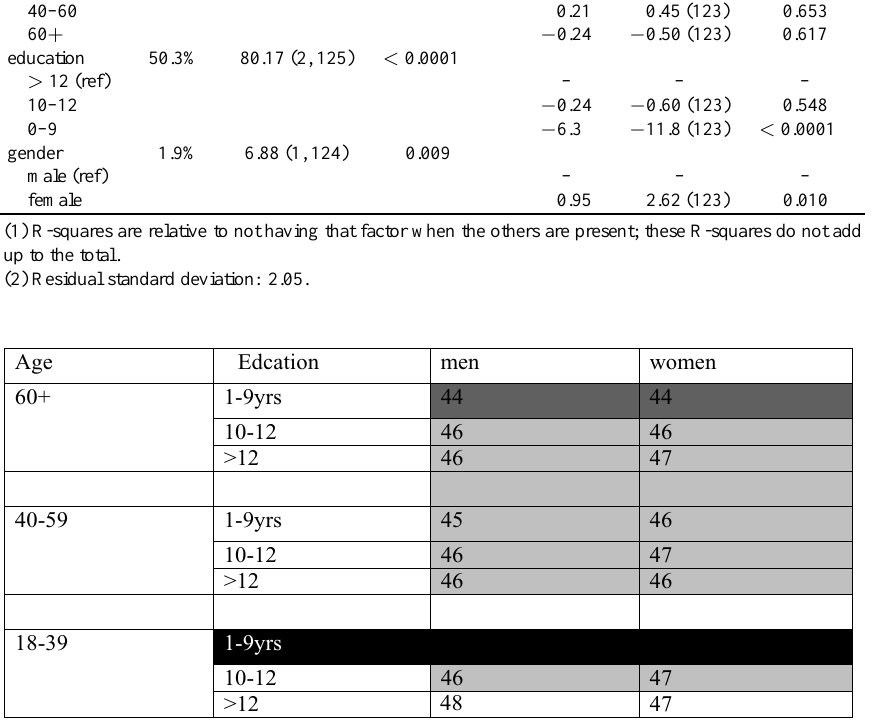
Fig. 1. Interaction between age and education in the oral expression subtest. Numbers in cells are average scores. Cells of common shade have average scores that are not statistically significantly different from each other. The averages (standard errors) for different shades are: 47.5 (0.3) for clear shade; 46.1 (0.1) for light grey; 43.9 (0.3) for dark grey; and black cells are